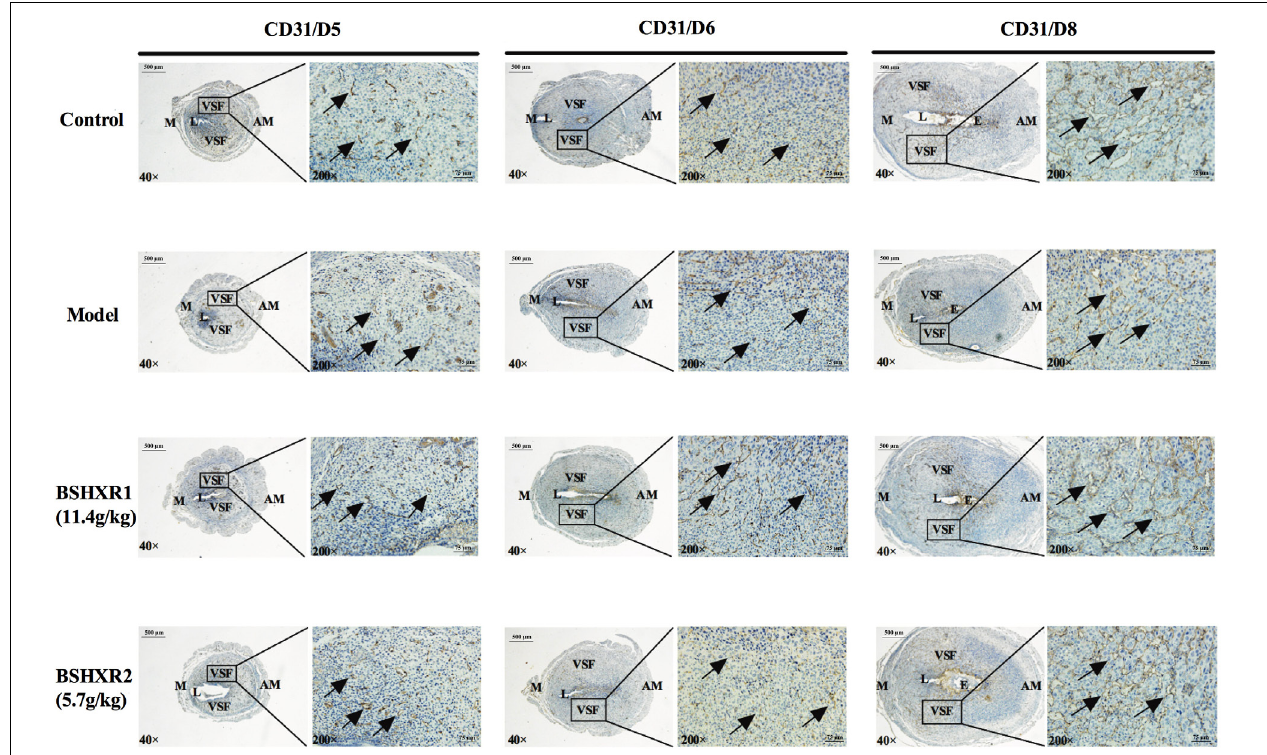
FIGURE 8 | Decidual angiogenesis of the pregnant uterus on D5, D6, and D8. Immunohistochemistry staining with cluster of differentiation 31 (CD31). The pictures on the right are the higher magnification images of VSF. Arrow represents the variable-sized blood vessels. E, embryo; L, lumen; M, mesometrial; AM, anti-mesometrial; VSF, vascular sinus folding. Original magnification and scale bar were shown in the